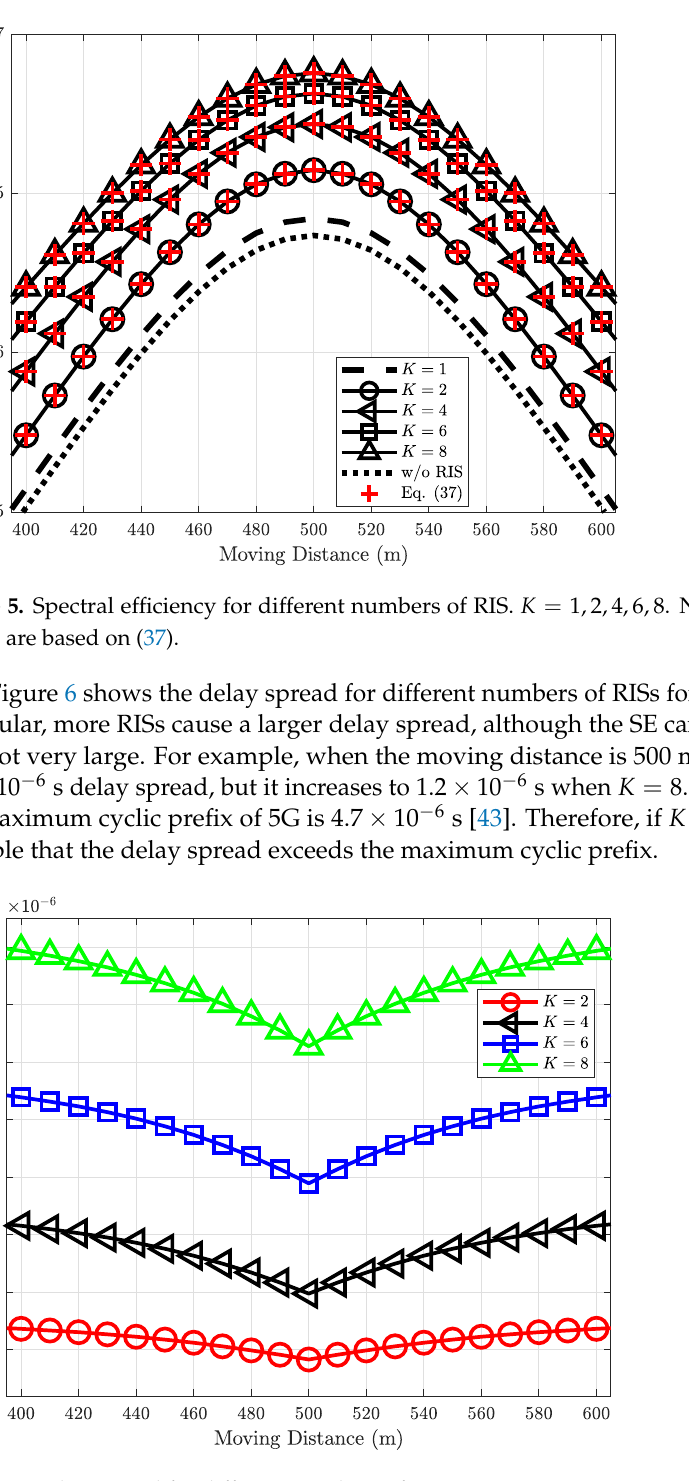
Figure 6. Delay spread for different numbers of RIS. K =